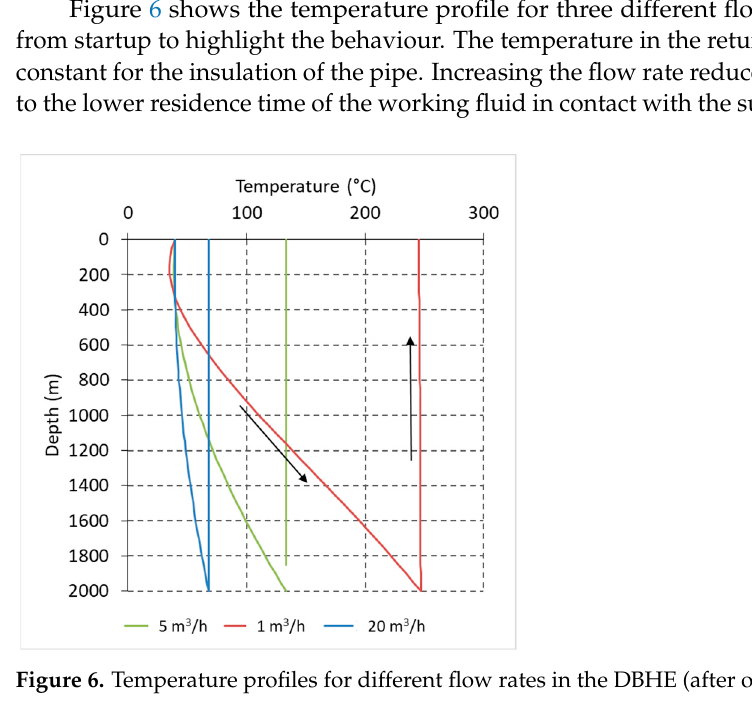
Figure 5. Results for the DBHE. ( a ) Thermal power vs outlet temperature and ( b ) efficiency vs out- let temperature.